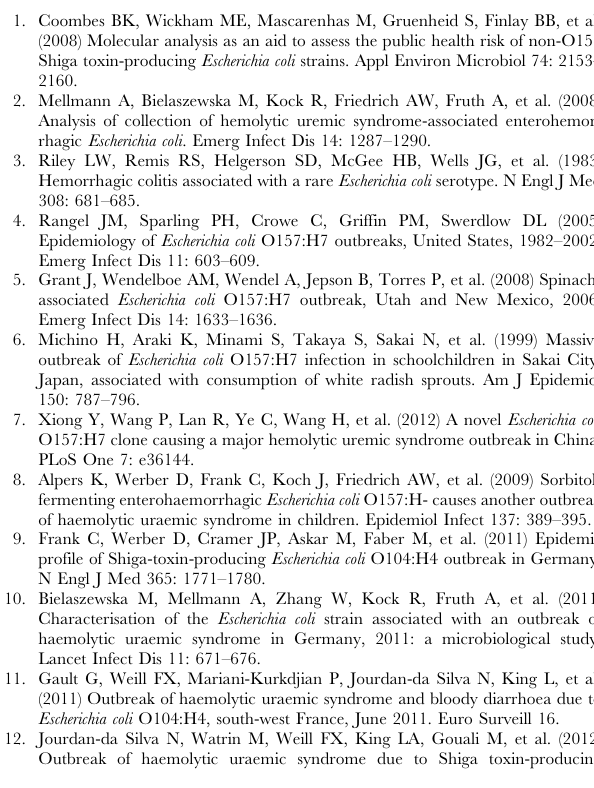
Figure 1. PFGE profiles of non-O157 STEC isolates from the yaks. The corresponding isolate names, PFGE patterns, no. of samples and herds, serotypes and stx 1 and/or stx 2 subtypes are listed on the right. For samples with more than 1 isolates, the numbers (x/y) in brackets in the sample column are number of strains (x) belonging to that PFGE pattern out of the total number of y isolates from that sample. Note that 5 isolates failed to produce a PFGE pattern and were not on the tree. For full list of isolates and their PFGE patterns and other data, see Table S1.